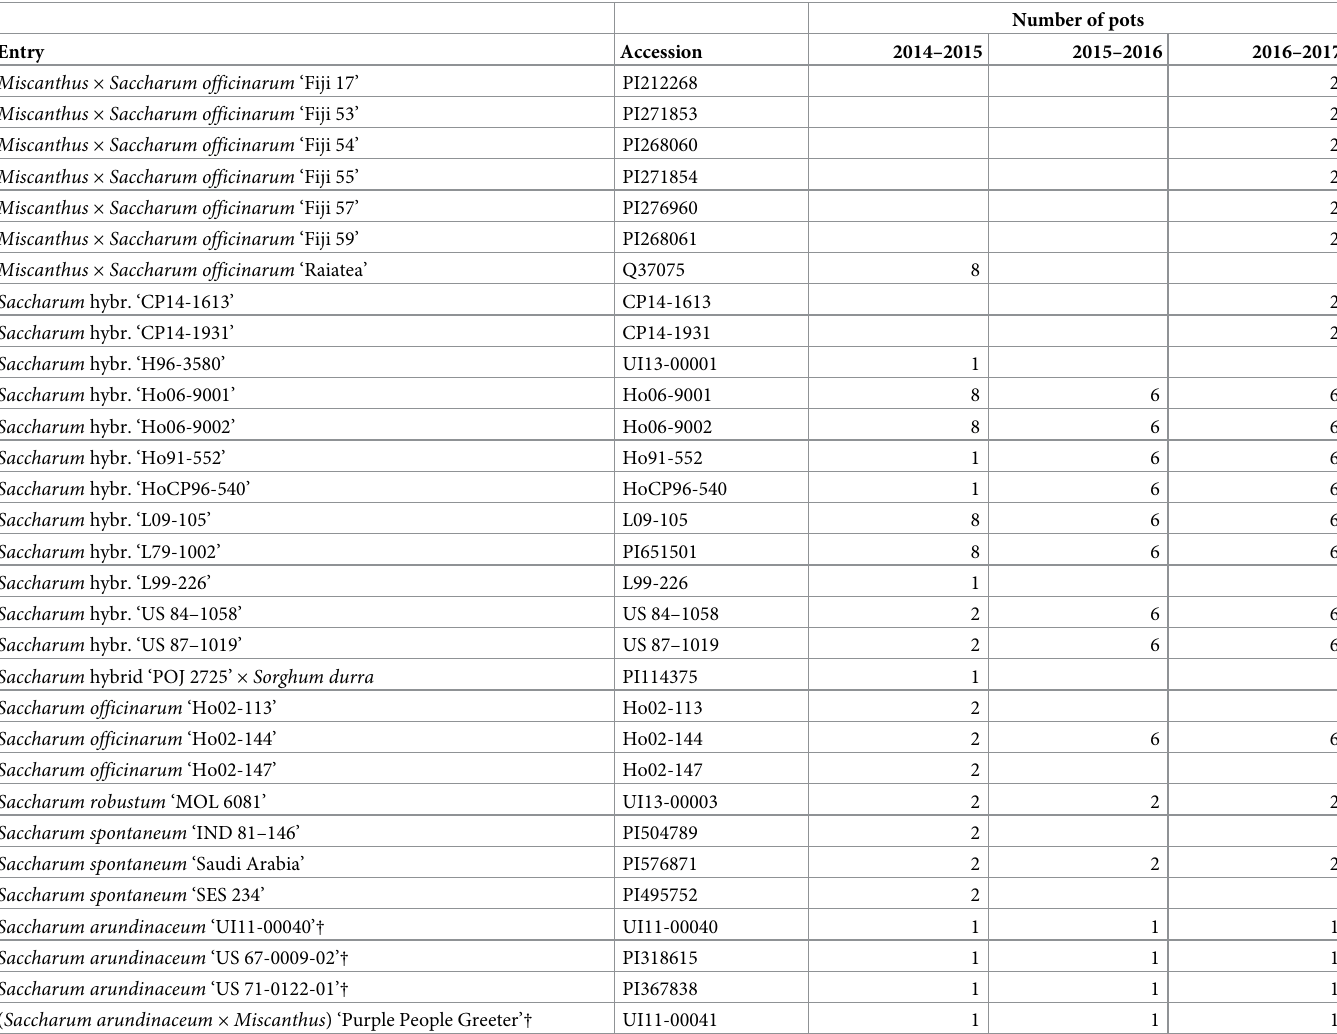
Table 2. Sugarcane and intergeneric hybrid genotypes included in a study of flowering time management in a greenhouse at Urbana, IL over three